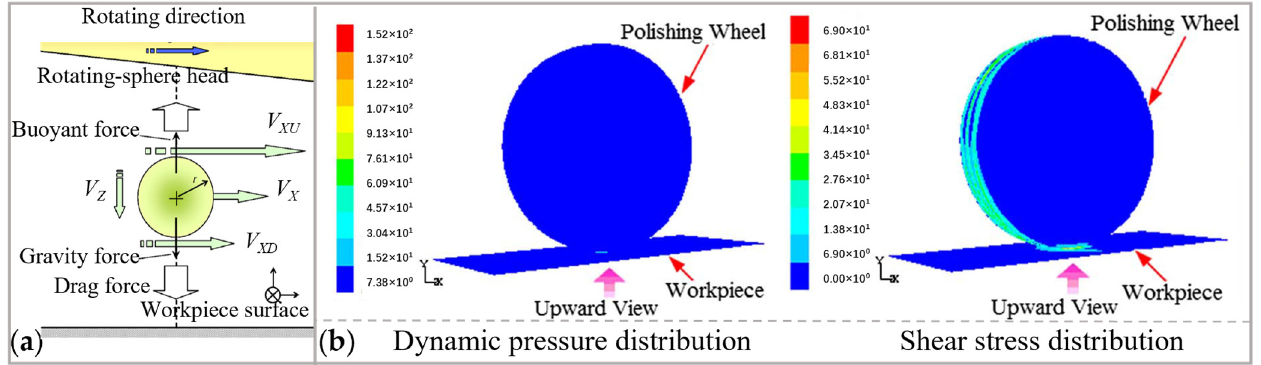
Figure 21. The material removal mechanism in elastic emission machining: ( a ) Schematic diagram of hydrodynamic effect [30]; ( b ) Distribution of dynamic pressure and shear stress under different clearances between the workpiece and polishing head [167].